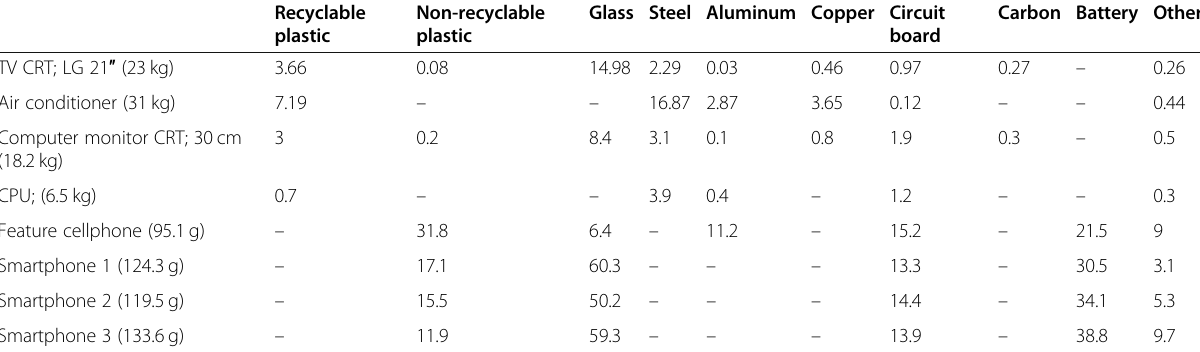
Table 2 E-waste components (kg or g per unit)